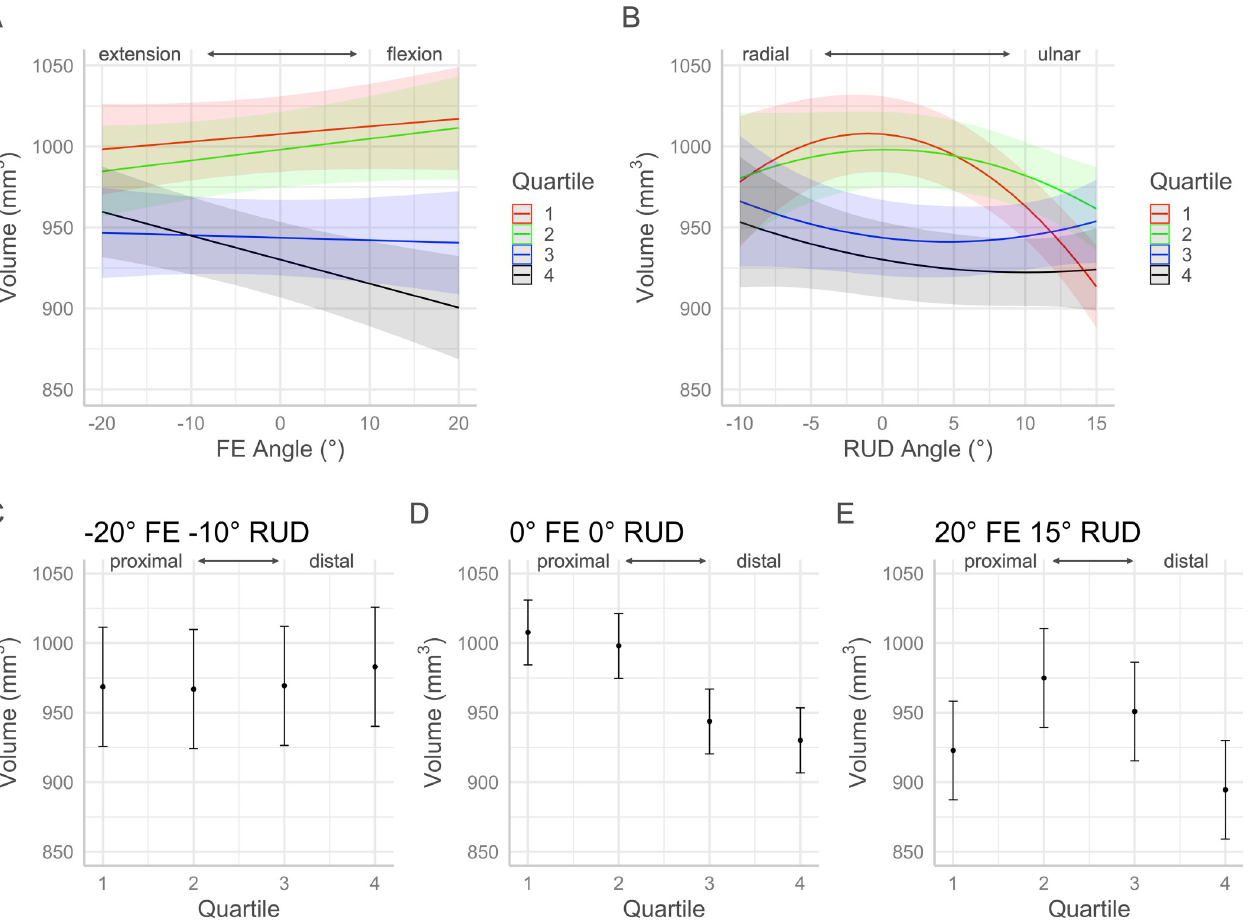
Fig 5. Effects of FE and RUD wrist postures on carpal tunnel volume distribution by quartile. Panel A shows the effects of varying FE angle with 0˚ RUD. Panel B shows the effect of varying RUD angle with 0˚ FE. Panels C/D/E show the predicted values with 95% confidence intervals for each quartile for an extended radially deviated posture (panel C), a neutral posture (panel D), and a flexed and ulnarly deviated posture (panel E).